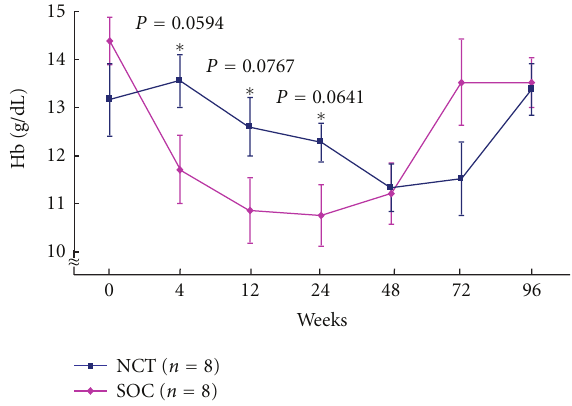
Figure 14: Changes in Hb level of peripheral blood during the NCT and the SOC in chronic hepatitis C patients with genotype 1 and high viral loads. NCT: novel combination treatment; cyclic and periodic IFN treatment (CPIT) consisting of induction treatment with natural interferon- β followed by maintenance treatment with natural interferon- α for 24 wks as induction approach followed by SOC for 48 wks. SOC: standard of care; ribavirin plus pegylated interferon α 2b for 48